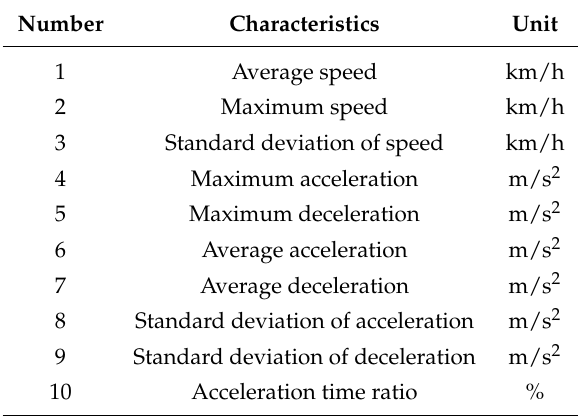
Table 2. Characteristics of driving